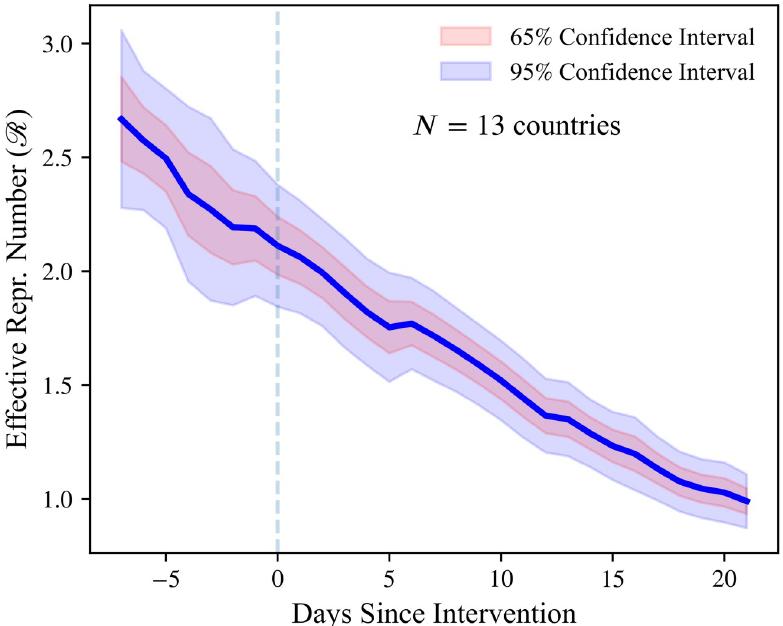
Fig 3. R and policy interventions: Lockdowns. Estimated effective reproduction number ( R three weeks after a lockdown is introduced in a country. The original sample consists of 14 European countries studied by Flaxman et al [25]. Heteroskedasticity-robust confidence bounds are shown by the shaded